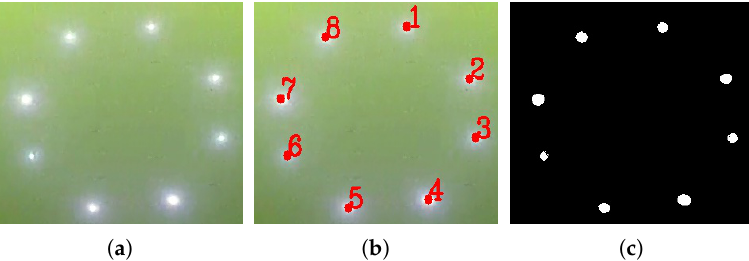
Figure 6. ( a ) Original image patch obtained by the coarse detection phase. ( b ) Definition of identification for ( a ). ( c ) Binary image of ( a ), computed by our proposed Laplacian-of-Gaussian-based coarse-to-fine blockwise (LCB) method, introduced in Section